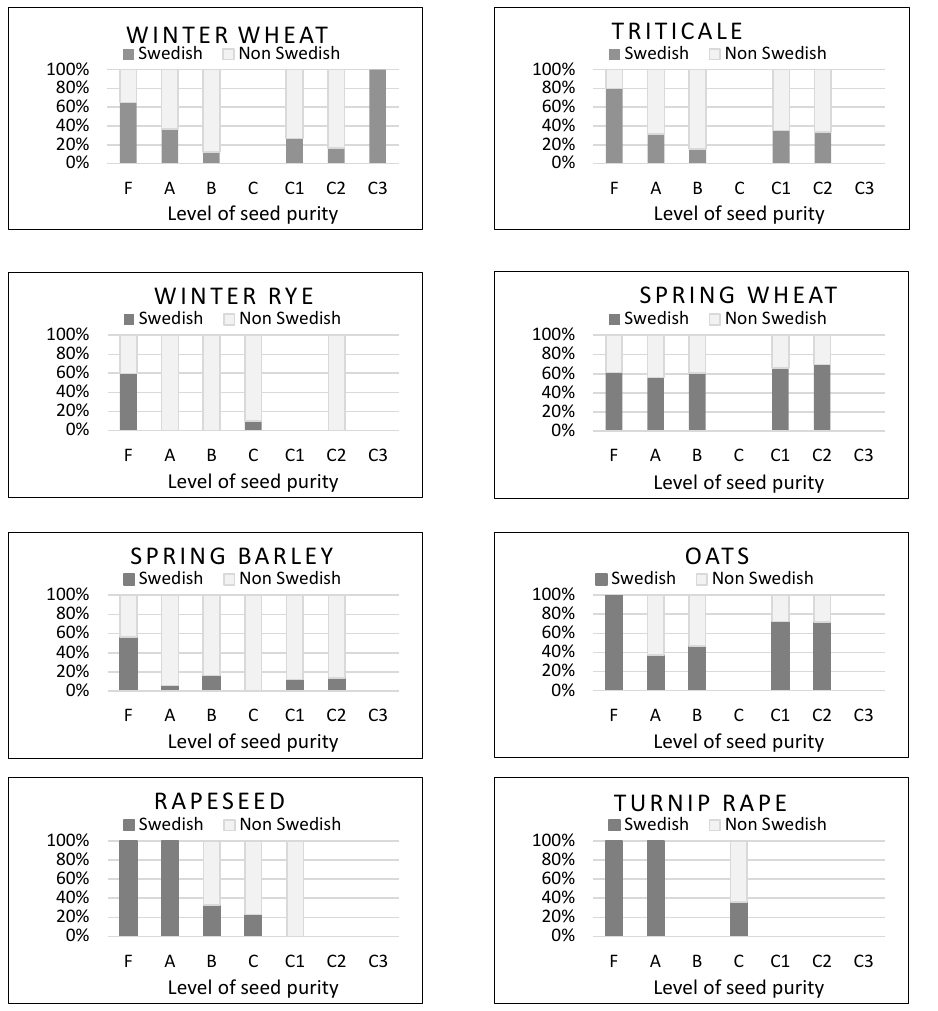
Fig. 4. Percentage of the volume of the production of certified seed from 2013–2015 that corresponds to Swedish-bred cultivars. Note: The level of seed purity decreases along the various classes; starting from class F that corresponds to nucleus seed to class C3, which corresponds to certified seed of 3rd generation of